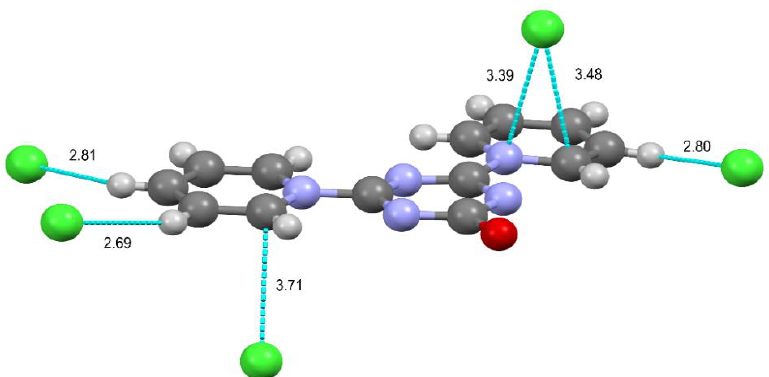
Figure 6. Cation in 4a surrounded by chloride anions and the shortest C-H...Cl, C...Cl and N...Cl contacts (Å ).